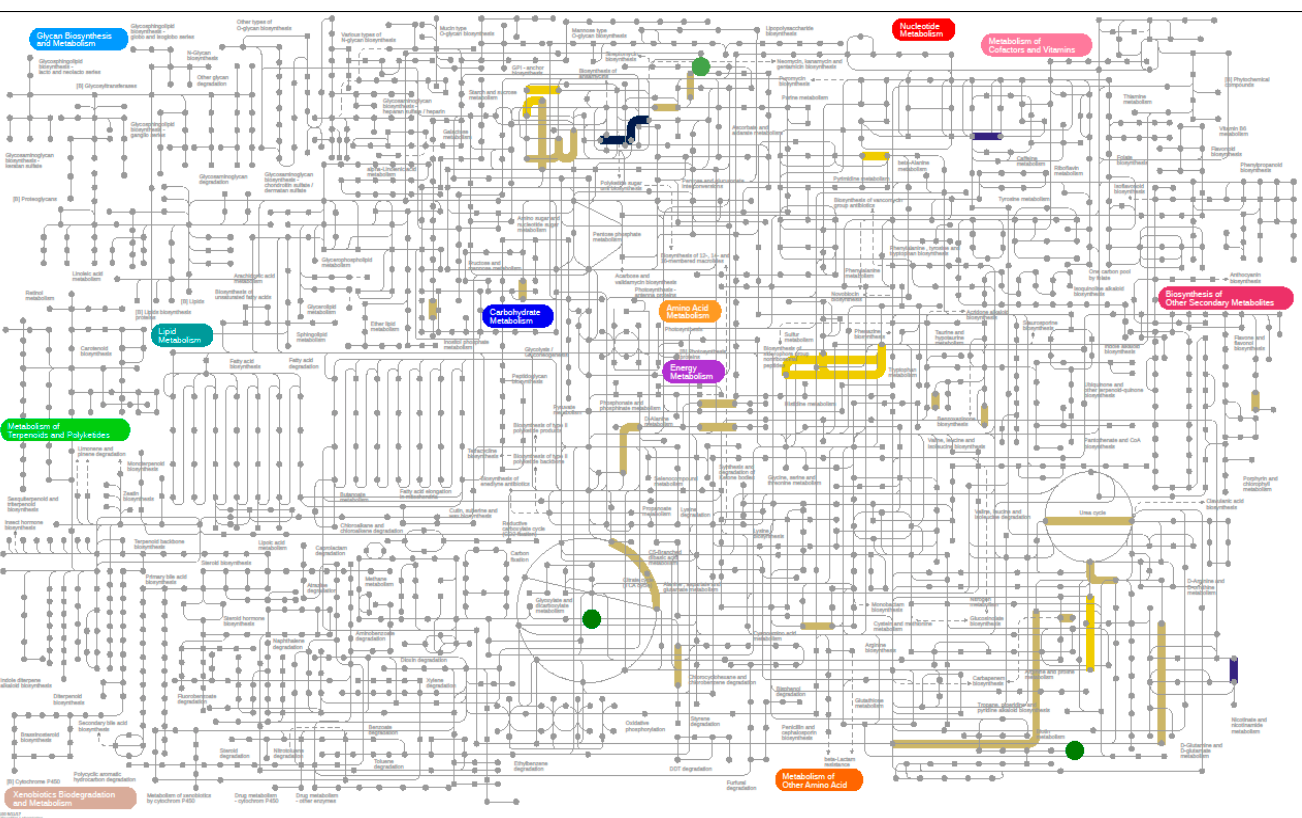
Figure 6. Functions and metabolites changing in abundance under the MSCD diet. For patients transitioned to the MSCD diet proteomics results, grouped by EC classification, from week 12 samples were compared against week 2 samples. Metabolites that increased over this time period are also highlighted (circles). Data is presented, as described in Figure 5. Interactive figures are available at https://pathways.embl.de/selection/9W7hzGUbabnlDYQQitH.